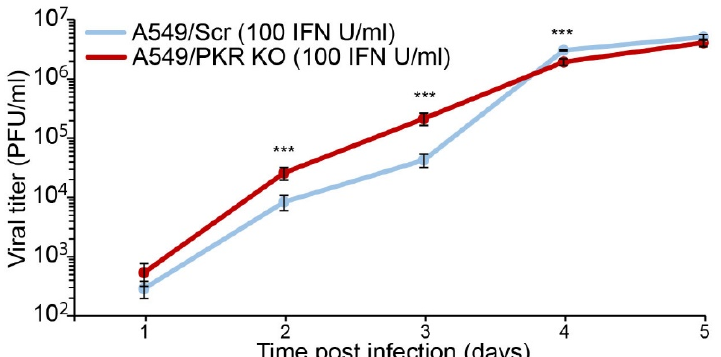
Figure 3. TCRV viral progeny production in IFN-stimulated A549/Scr and A549/PKR KO cells. Cells were stimulated with 100 IU/mL of rIFN- α A/D 24 h before infection. Cells were infected at MOI 0.01 PFU/cell and supernatants were assayed for viral titer by IFA. Error bars represent standard deviations ( n = 4) and asterisks (***) means statistical significance ( p < 0.01) in two-way ANOVA